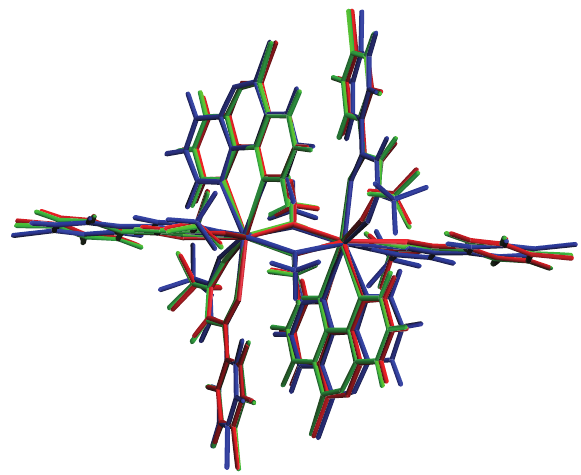
Figure 5: Comparison of the Sparkle/PM6 (blue) and Sparkle/PM7 (green) optimized geometries with the X-ray geometry (red) of complex 2 (software used for visualization: VMD version 1.9.1